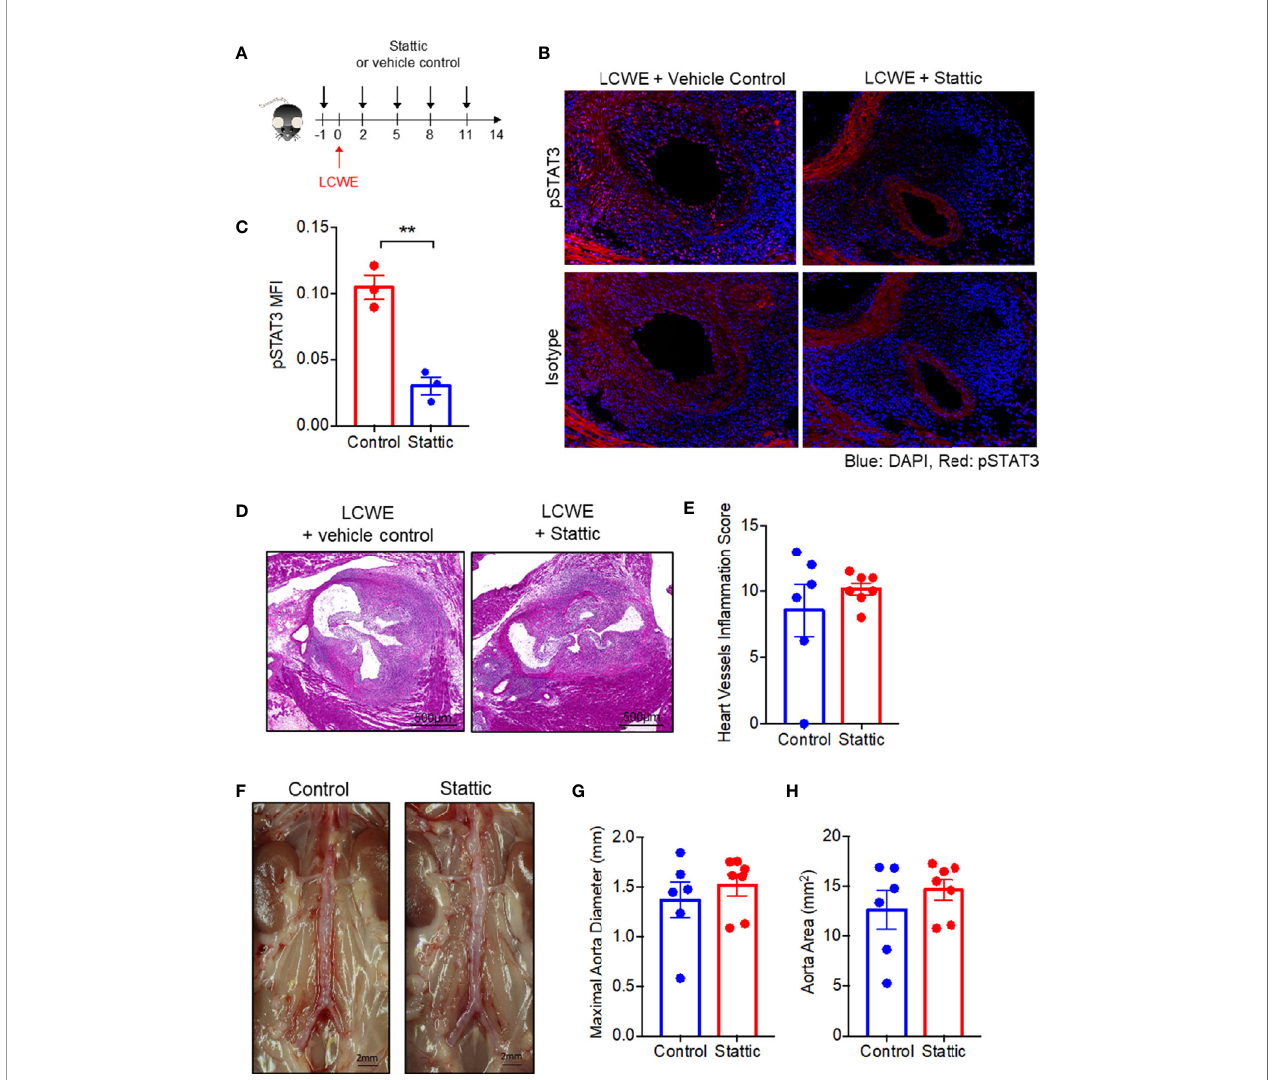
FIGURE 4 | STAT3 inhibition fails to attenuate LCWE-induced KD vasculitis. (A) Schematic of the experimental design. (B) Representative images of pSTAT3 immuno fl uorescence staining in murine heart tissue from LCWE-injected mice treated with vehicle control of Stattic. (C) Quanti fi cation of pSTAT3 immuno fl uorescence staining in murine heart tissue. (D, E) Representative H&E stained heart sections (D) and heart vessel in fl ammation scores (E) of LCWE-injected WT mice treated with either vehicle control or the STAT3 inhibitor Stattic at 2 weeks post-LCWE injection. Scale bars, 500µm. (F) Pictures of the abdominal aorta of LCWE-injected WT mice treated with either vehicle control or Stattic at 2 weeks post-LCWE injection. (G, H) Maximal abdominal aorta diameter (G) and abdominal aorta area (H) of LCWE-injected WT mice treated with either vehicle control or Stattic at 2 weeks post-LCWE injection. Results are representative of two independent experiments (n = 6-7 mice per group). Data was analyzed by Student ’ s t test. ** p <